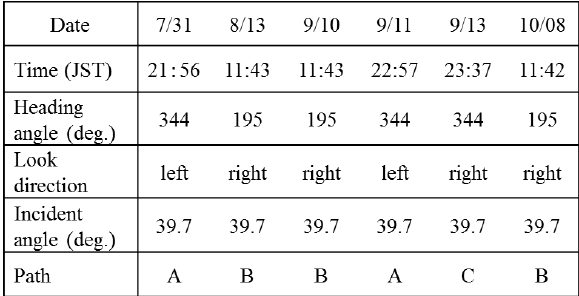
Table 1. Acquisition conditions of the six ALOS-2 images used